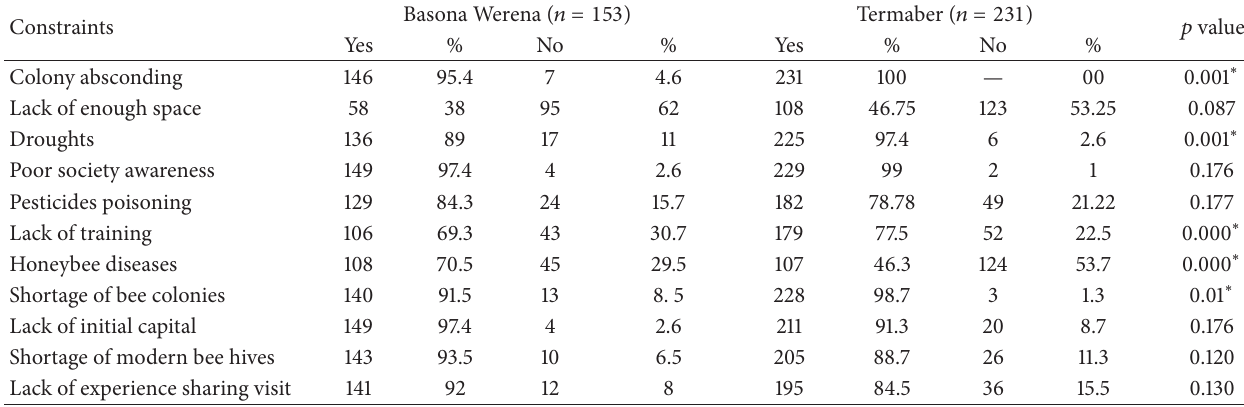
Table 8: Constraints associated with beekeeping reported from the study